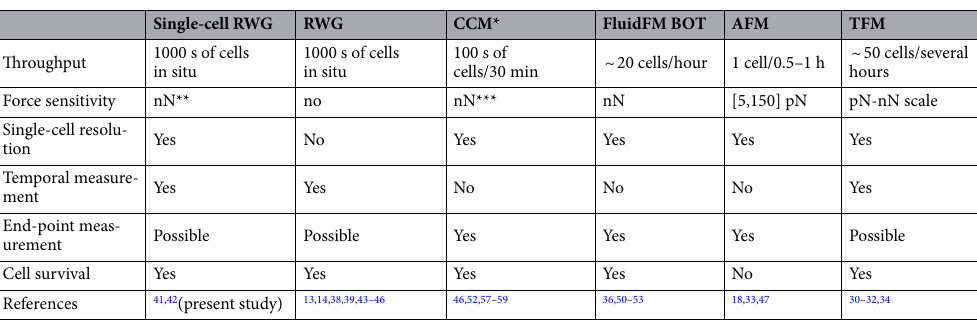
Table 1. Comparative table to overview the capabilities of different cell adhesion measurement techniques 36 . RWG biosensors are generally used to measure thousands of cells simultaneously from the time of suspending the cells in the medium until completely adhered, novel RWGs even have single-cell resolution capabilities. An alternative measurement is also possible when completely adhered cells are measured for a short amount of time, as discussed in this study. The computer-controlled micropipette, FluidFM, and AFM are all capable of single-cell measurements, but the time needed to measure a cell varies greatly, as well as the scale of the force sensitivity. *CCM is an abbreviation for computer-controlled micropipette. **when calibrated using FluidFM BOT 41 . ***This value is based on numerical simulations on the lifting force of microbeads 60 , and on direct comparison with FluidFM BOT force data 53